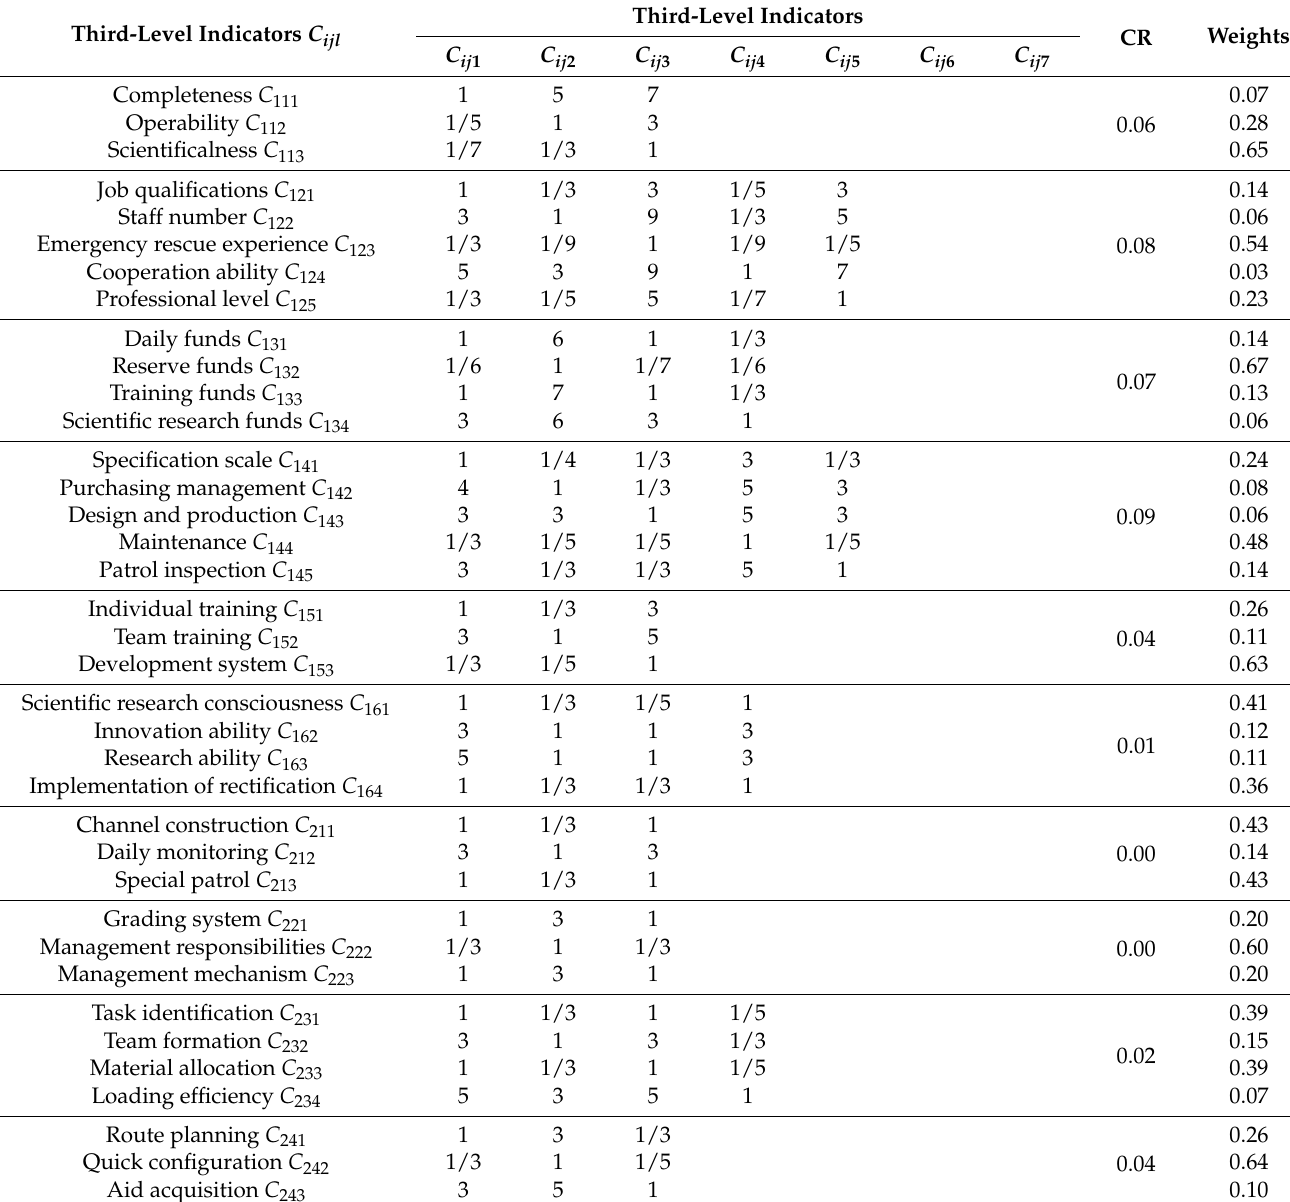
Table A10. Judgment matrices and weights of third-level assessment